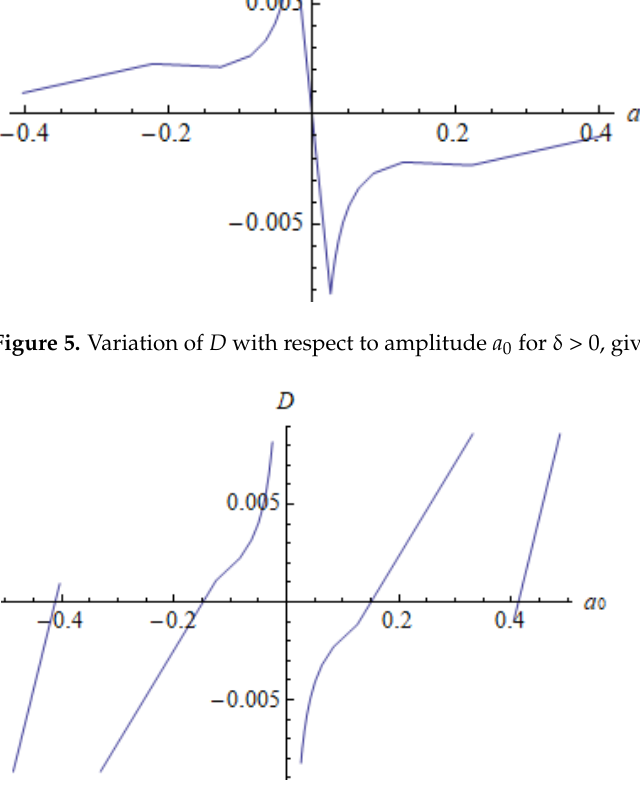
Figure 6. Variation of D with respect to amplitude a 0 for δ < 0 , given by Equation (77). Commented [M41]: Please replace with a sharper